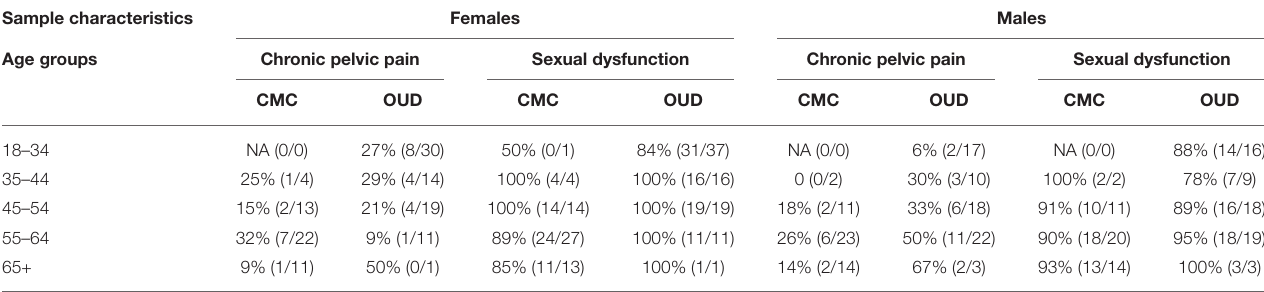
TABLE A1 | Age and sex specific prevalence of Chronic Pelvic Pain and Sexual Dysfunction amongst females and males in the CMC and OUD groups. Sample